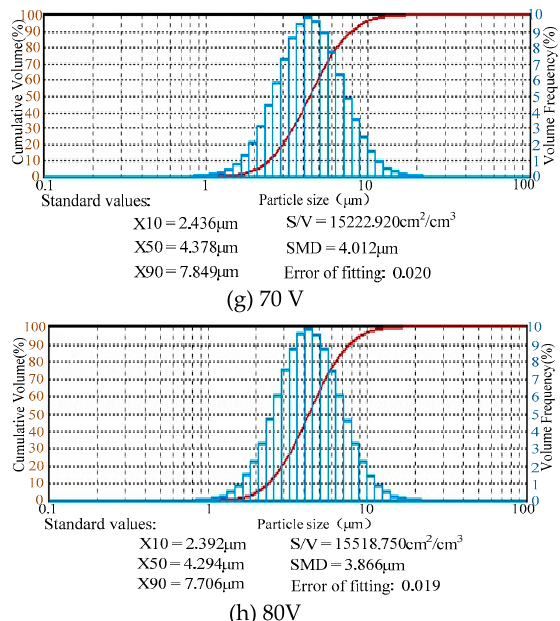
Figure 13. Cumulative particle size distribution and analysis results of atomized particles under different working voltages. (X10 is the percentage of cumulative distribution reaches 10%, the corresponding particle size is obtained, X50 is median size, X90 is the percentage of cumulative distribution reaches 10%, the corresponding particle size is obtained, S / V is the surface area specific volume of atomized droplets, SMD is the average diameter of sotail).